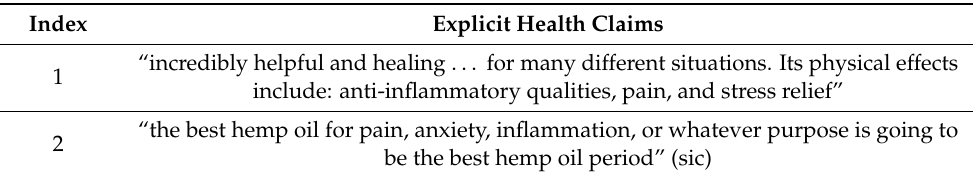
Table 1. Explicit health claims made by the vape shops that appeared in the first two pages of Google search results of queries indicative of shopping for vaping products, June 2020.